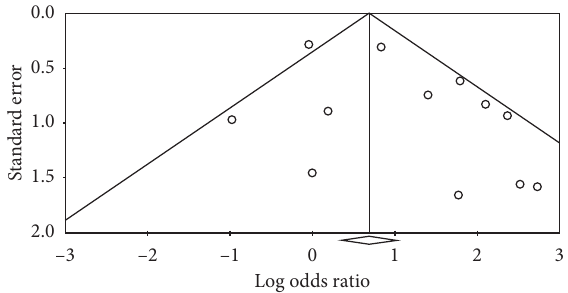
Figure 3: Funnel plot to examine publication bias in this